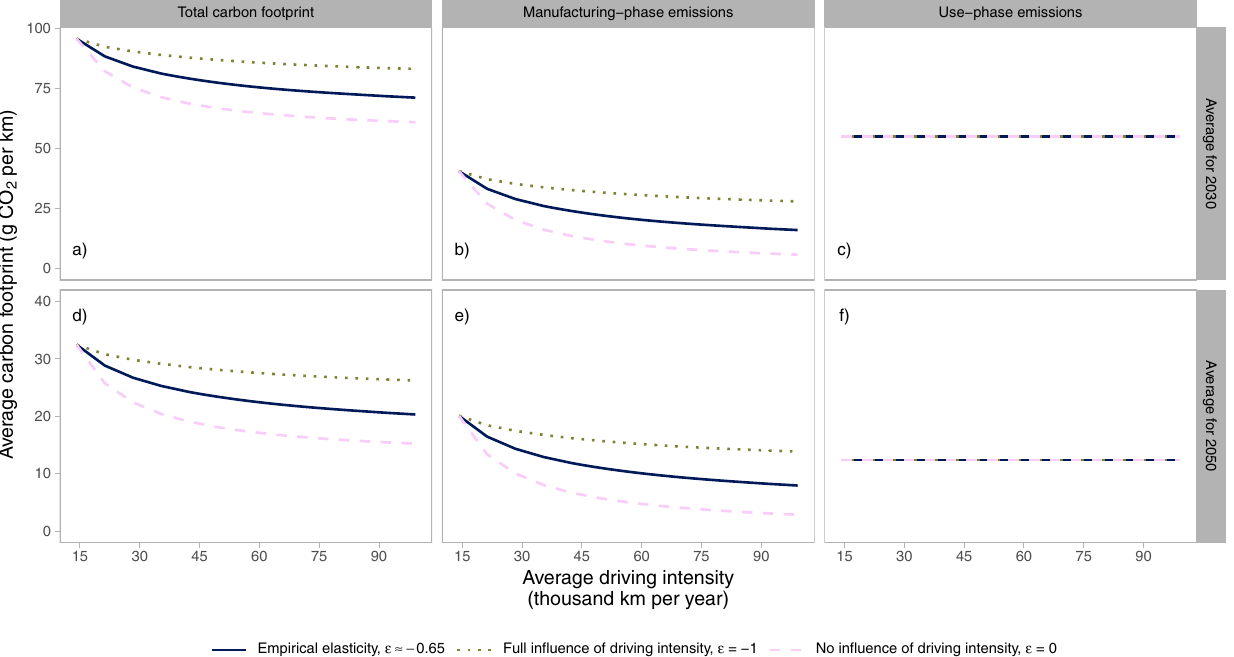
semi-empirical lifetime-intensity model (solid: empirical elasticity, ε ≈ − 0.65, dot- ted: full in fl uence of driving intensity, ε = − 1, and dashed: no in fl uence of driving intensity, ε = 0). The results assume that global manufacturing and electricity generation decarbonize in line with the Paris Agreement ’ s